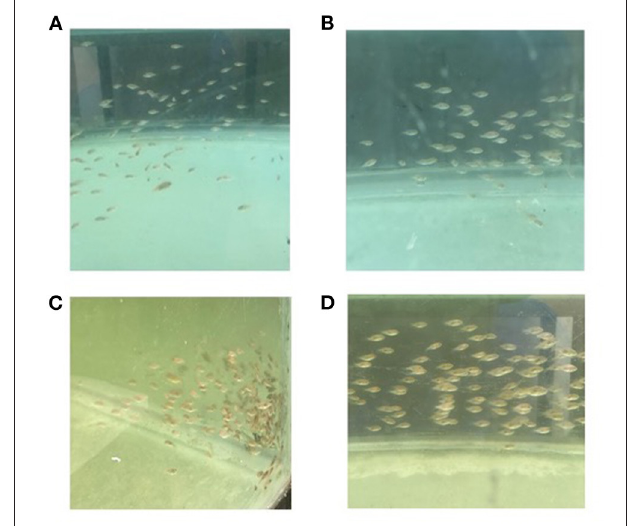
FIGURE 5 | Group behavior of tilapia Oreochromis niloticus alevins in aquarium. (A, B) . Negative control (culture water). (C, D) Treatment with Caesalpinia spinosa aqueous